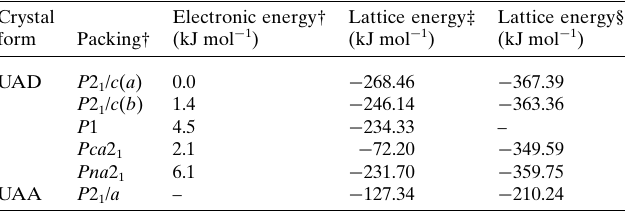
Table 2 Lattice energies of five potential packing arrangements ( P 2 1 / c ( a ), P 2 1 / c ( b ), P 1, Pca 2 1 and Pna 2 1 ) of UAD and crystal packing of UAA. Crystal form